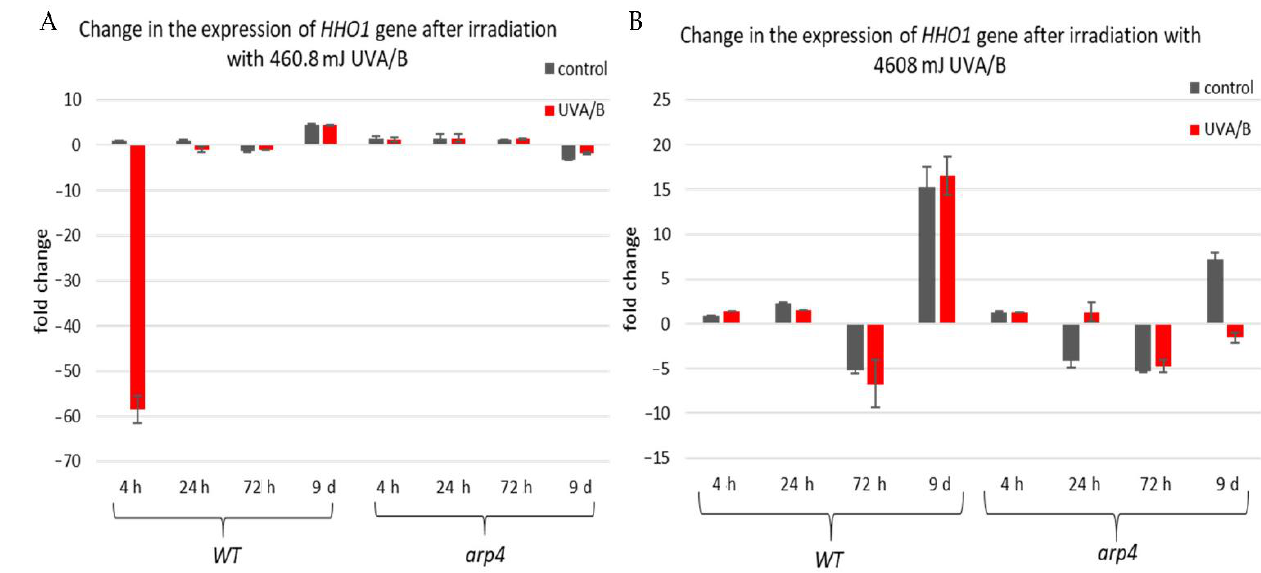
Figure 6. Change in the expression of HHO1 gene after irradiation with low- and high dose UVA/B. ( A ) 3 min (460.8 mJ). ( B ) 30 min (4608 mJ). Three repetitions of the experiment were performed and results are MEAN fold change ± STDV.